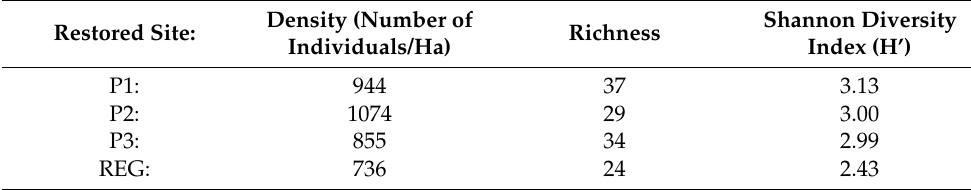
Table 1. Characteristic of the vegetation cover on restored areas, Fazenda Dourada, Brazil. P1: ac- tive/slop; P2: active/slop; P3: active/flat; and REG: natural regeneration, adapted from Galv ã o